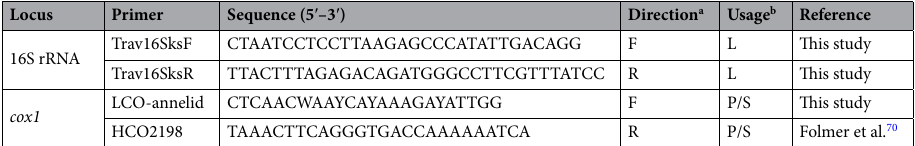
Table 4. The primer sequences used in the present study. a F forward, R reverse. b L long PCR, P PCR, S